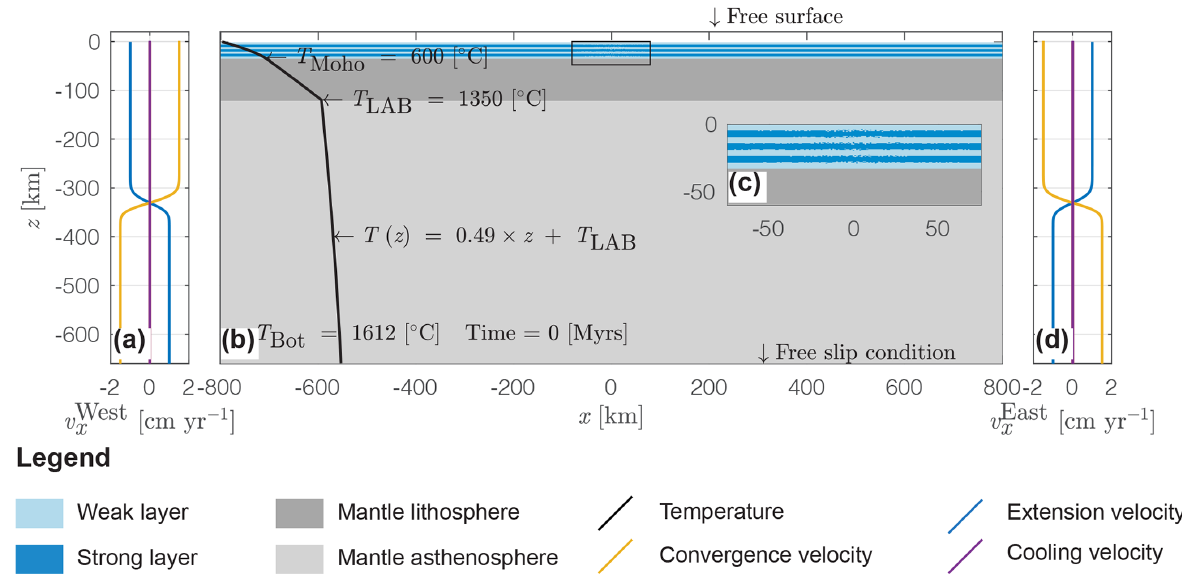
Figure 1. Initial model configuration and boundary conditions. Dark blue represents strong and light blue represents weak crustal units; dark grey represents the mantle lithosphere and light grey the upper mantle. (a) Profile of horizontal velocity for material inflow and outflow along the western model boundary. The blue line indicates the profile for the extension, the purple line indicates the profile for the cooling and the yellow line indicates the profile for the convergence stage. (b) Entire model domain including the material phases (colour code as explained above) and initial vertical temperature profile (black line). (c) Enlargement of the centre of the model domain showing the initial random perturbation on the marker field (see Appendix A) used to localize deformation in the centre of the domain; panel (d) is the same profile as shown in (a) but along the eastern model boundary. Table 1. Parameters varied in models M1–6. Parameter Unit M1